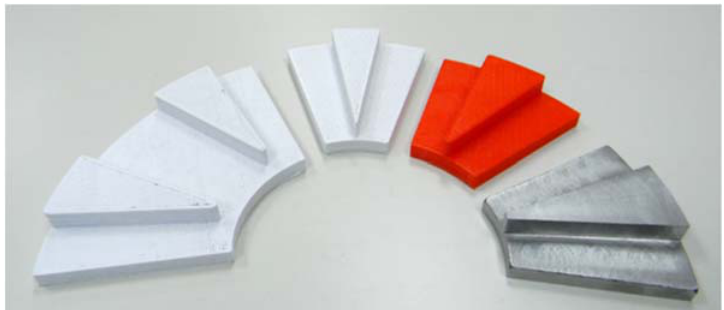
Figure 13. Evolution of rotor pole pieces.